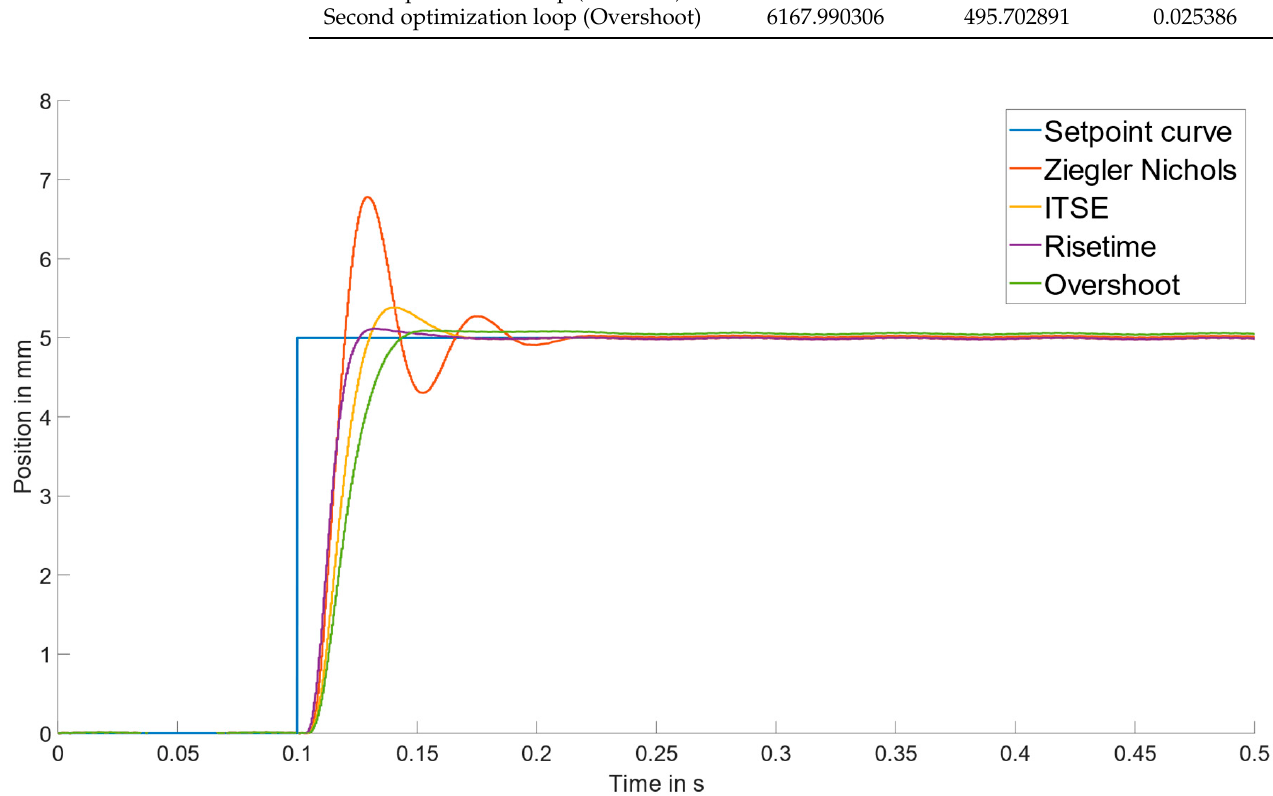
Figure 5. Step responses for the EHA simulation model for the PID parameters presented in Table 3 for the inertia of 11.8 kg.